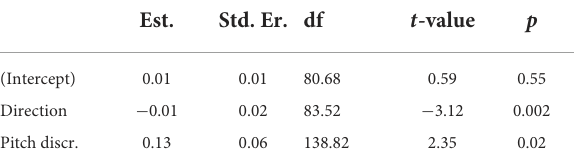
of pitch discrimination accuracy ( β = 0.130, t = 2.351, p = TABLE 2 Regression analysis of f 0 -motion mapping congruency (Follow-up